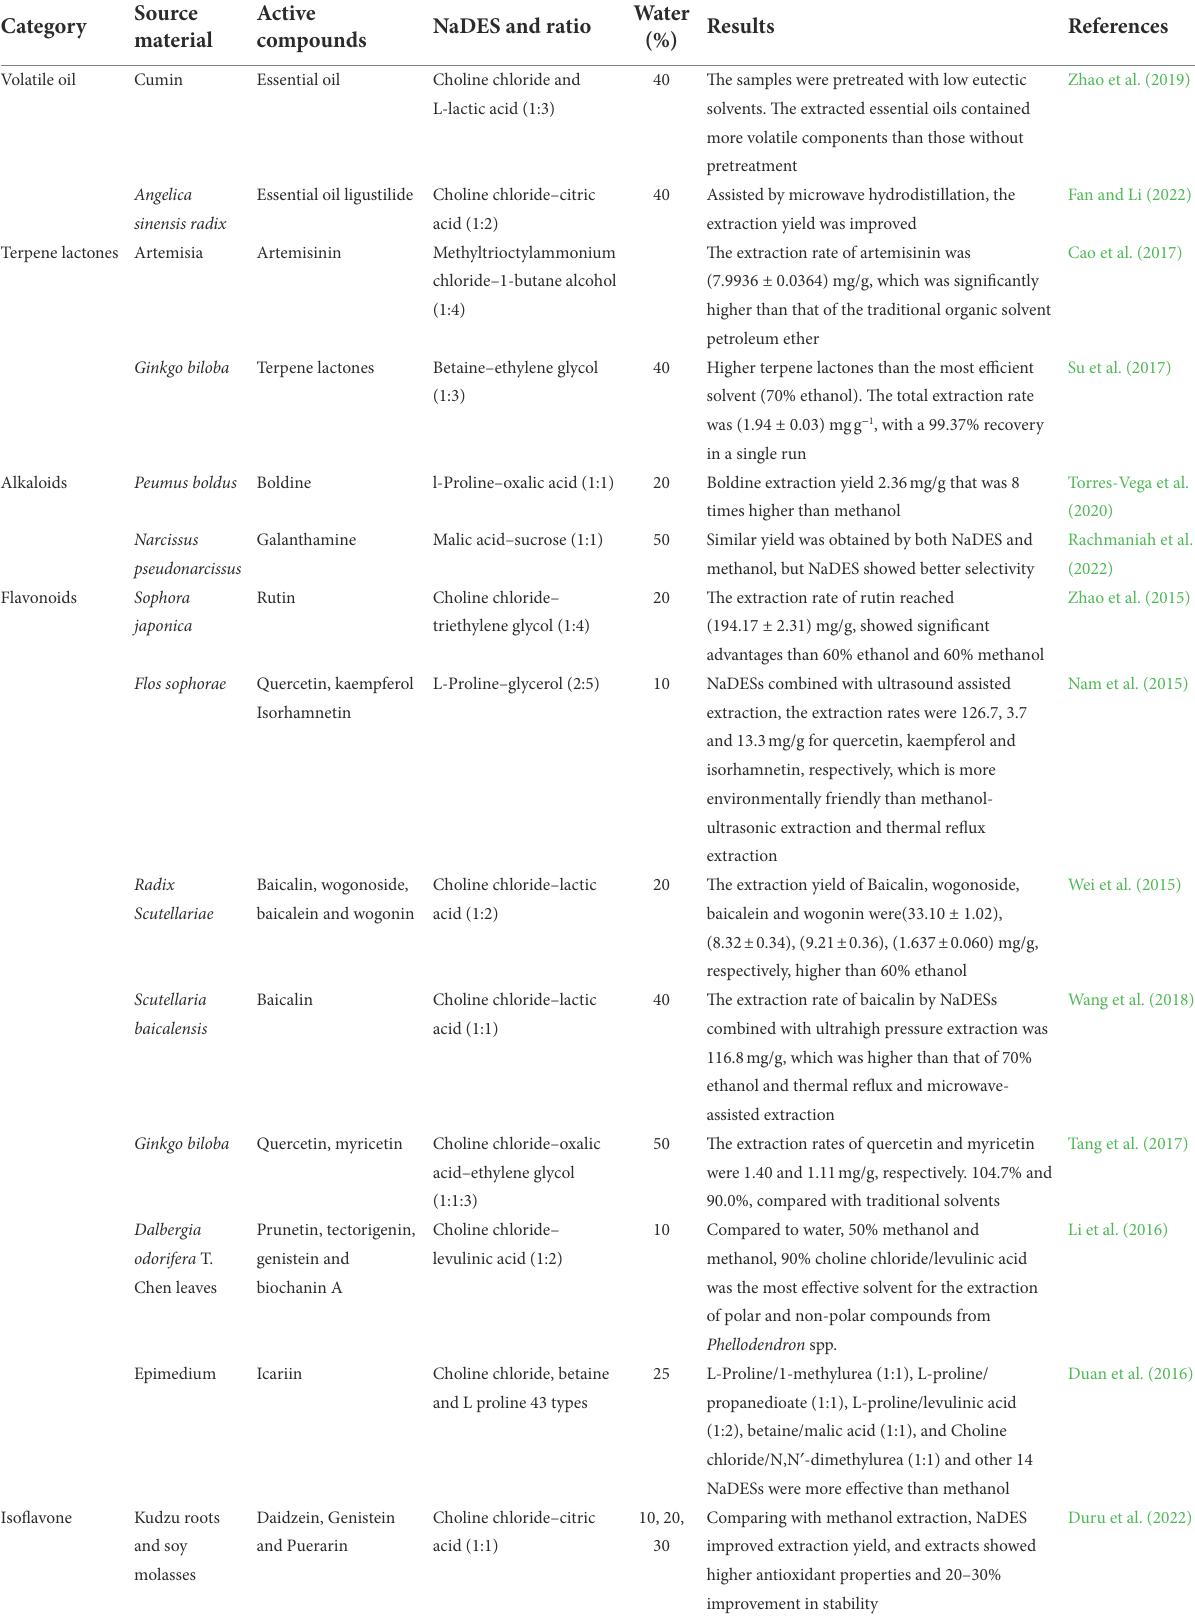
TABLE 1 Examples of application of NaDESs in the extraction of phytonutrients from botanicals.